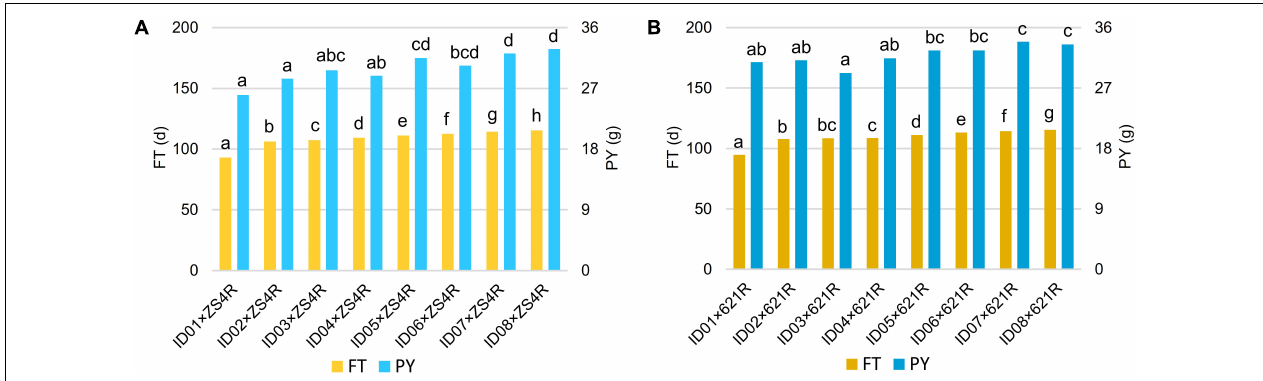
FIGURE 7 | Multiple comparisons of FT and PY of the non-NIL hybrids. (A) Multiple comparisons of the hybrids produced by crossing with ZS4R. (B) Multiple comparisons of the hybrids produced by crossing with 621R. The left bars indicate FT (d), and the right bars indicate PY (g). The left legend stands for FT (d), and the right legend stands for PY (g), and the lower-case letters next to the bars showed the significance of multiple comparisons.